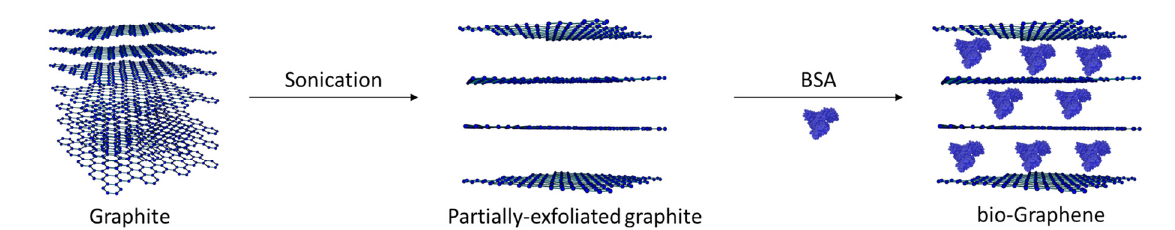
Figure 1. Schematic presentation of the production of bio-Graphene.